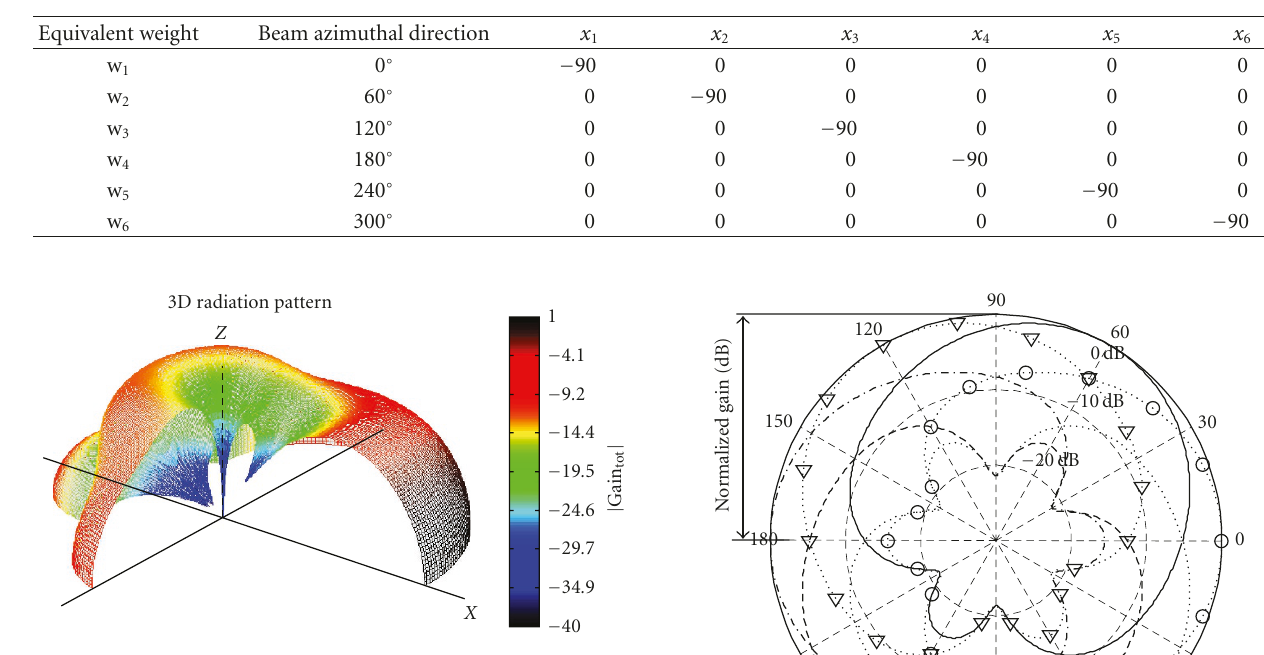
Figure 2: Three-dimensional beam pattern of a 7-element ESPAR antenna that is calculated by NEC simulator. X = [ − 9 000000] Ω . The directional beam pattern is pointing to 0 ◦ in the azimuthal plane.